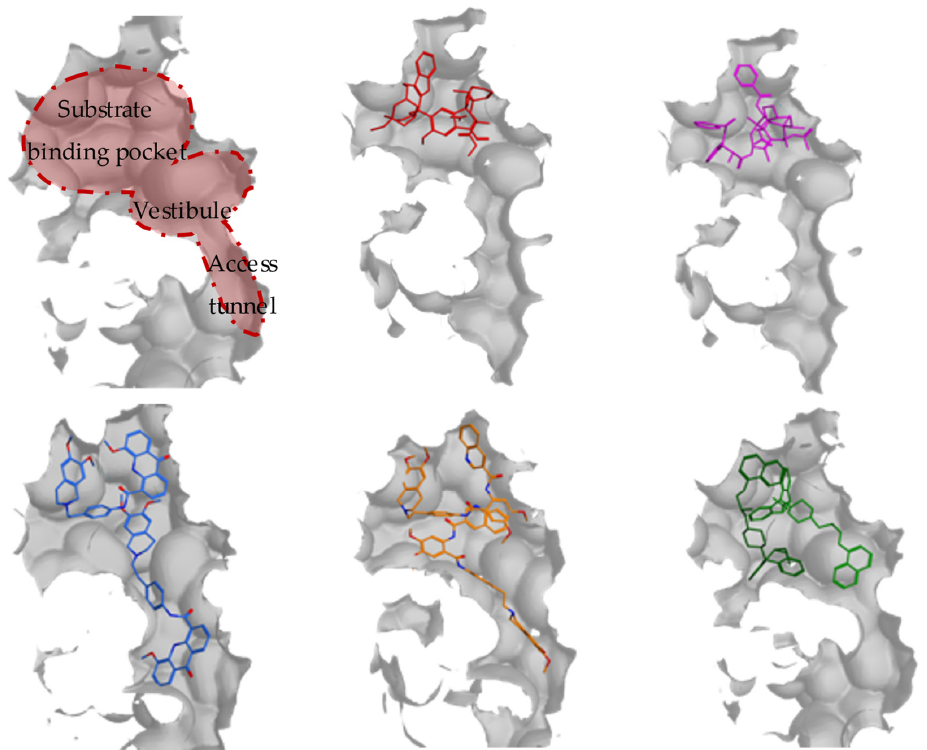
Figure 1. The Interaction surface of various ABCB1 cryo-EM structures with their bound substrates or inhibitors. The substrate binding pocket, vestibule and access tunnel are marked out in a red area, while one molecule of substrate vincristine (in red, from 7A69), taxol (in rosa, from 6QEX) and two molecules of inhibitors elacridar (in blue, from 7A6C), tariquidar (in orange, from 7A6E), zosuquidar (in green, from 6QEE) are shown as sticks.